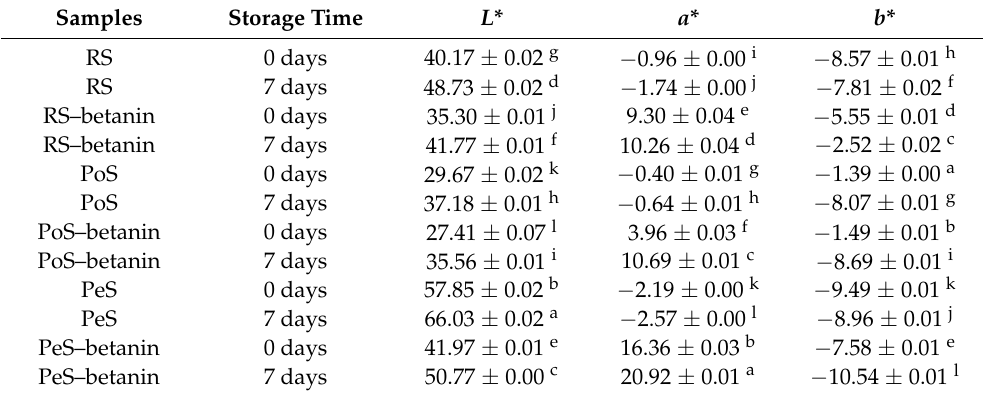
Differences between values, indicated by different letters in the same columns, are significant at 0.05 level of confidence. RS: rice starch; PoS: potato starch; PeS: pea starch; L *: brightness value; a *: red-green value; b *: yellowish-blue